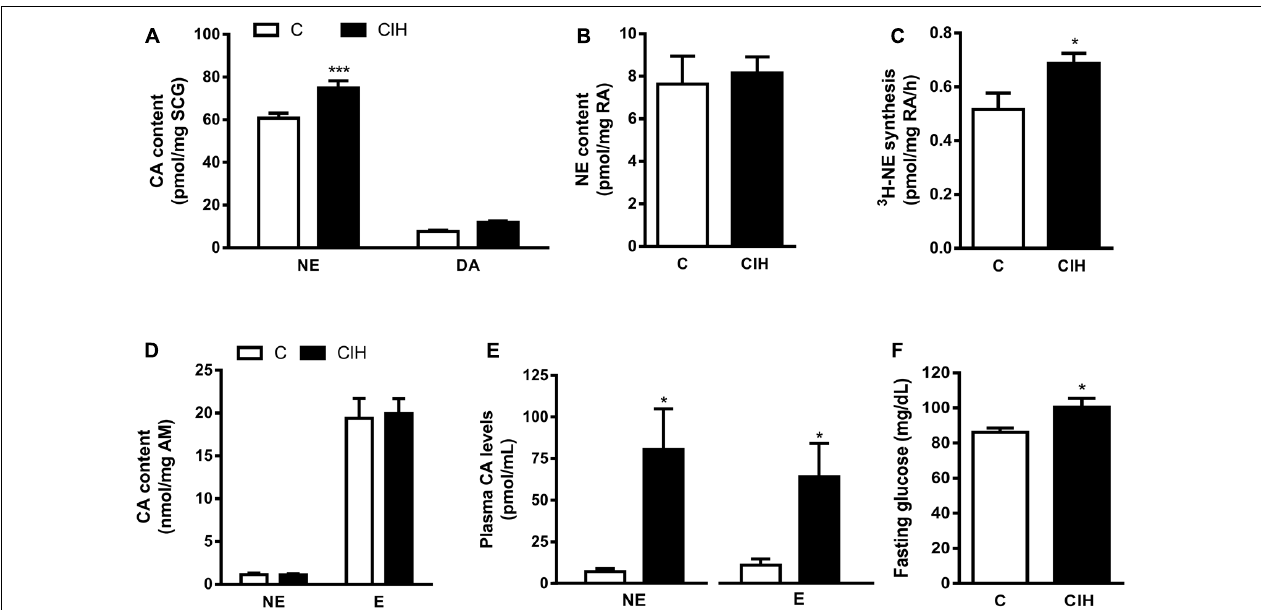
FIGURE 4 | Sympathetic activity in tissues from control and CIH guinea pigs. (A) Superior cervical ganglion (SCG) endogenous content of norepinephrine (NE) and dopamine (DA) expressed as pmol/mg tissue in control and CIH measured by HPLC-ED. ∗∗∗ p < 0.0001 CIH vs. C. Data are mean ± SEM ( n = 14–16). Two-way ANOVA with Sidak’s multiple comparison test. (B) Renal artery (RA) endogenous NE levels expressed as pmol/mg tissue. Data are mean ± SEM ( n = 6–7); Unpaired t -test. (C) Rate of 3 H-NE synthesis expressed as pmol/mg tissue/h in RA. ∗ p < 0.05 CIH vs. C. Data are mean ± SEM ( n = 6–7); Unpaired t -test. (D) Adrenal medulla (AM) endogenous content of NE and epinephrine (E) expressed as nmol/mg tissue. Data are mean ± SEM ( n = 14–16); Two-way ANOVA with Sidak’s multiple comparison test. (E) Plasma NE and (E) levels expressed as pmol/mL. ∗ p < 0.05 CIH vs. C; Data are mean ± SEM ( n = 6–8); Unpaired t -test. (F) Fasting glucose plasma levels expressed as mg/dL. ∗ p < 0.05 CIH vs. C; Data are mean ± SEM ( n = 16); Unpaired t